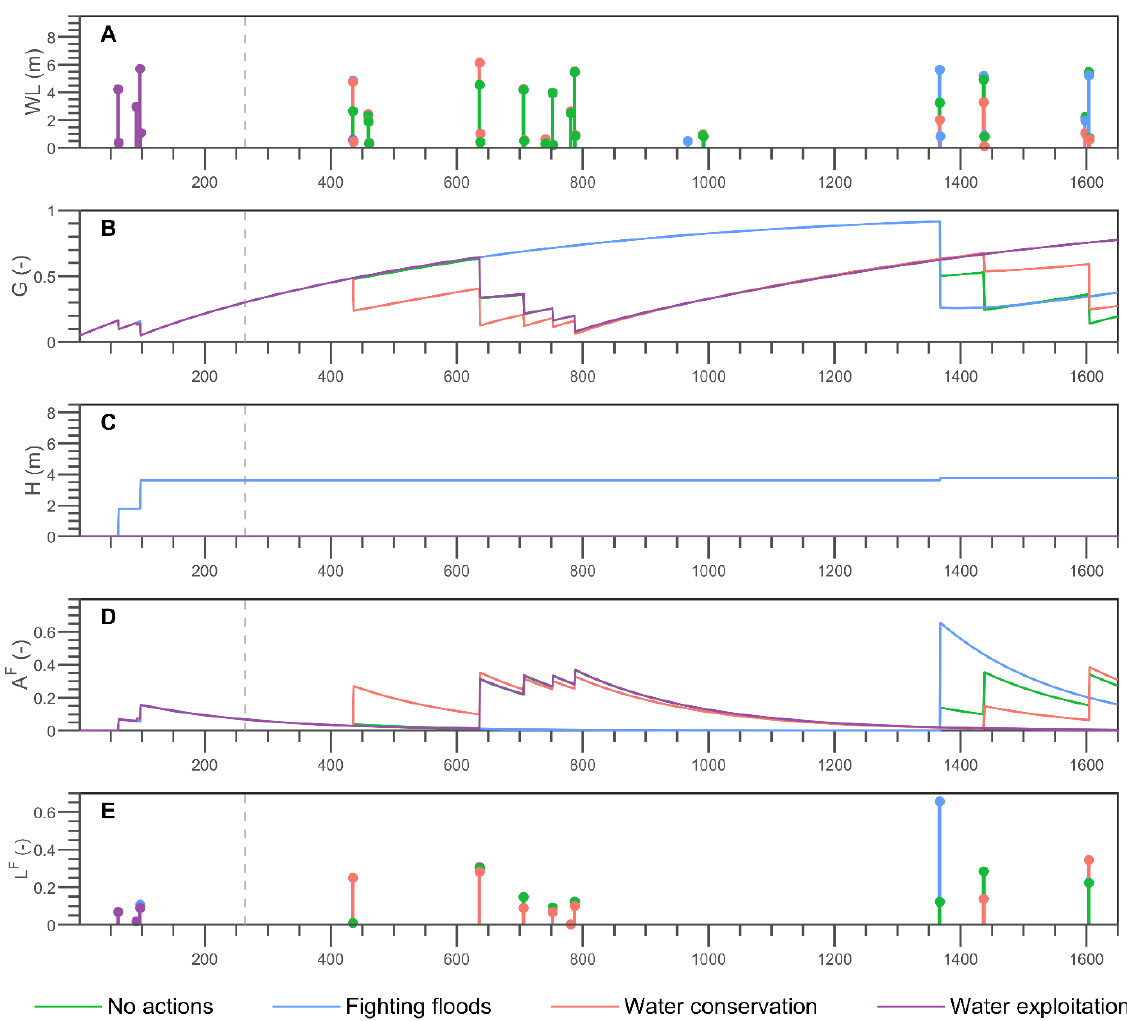
Figure A18. Flooding-based variables of the synthetic experiments additional scenario #5 considering dam construction and human-flood interactions with the four water management strategies introduced in this study. (A) Water level (WL), (B) proportion of population in floodplain (G), (C) levee height (H), (D) flood awareness (AF), and (E) flood losses (LF). The grey dashed line indicates the construction of the Wivenhoe